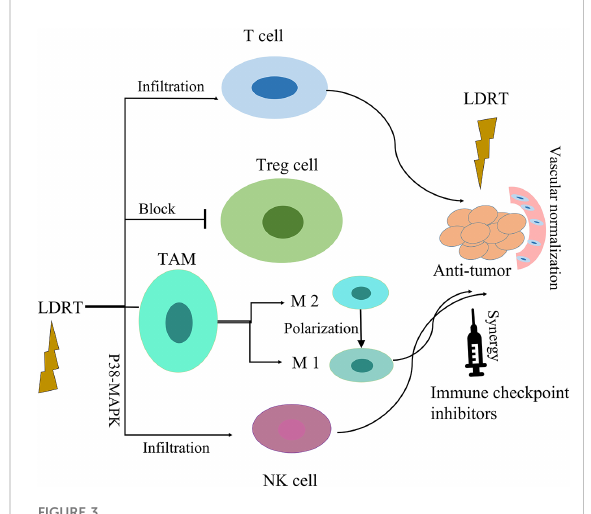
FIGURE 3 Immunomodulatory effects of LDRT in tumor microenvironment. LDRT modulates the tumor microenvironment by repolarizing macrophages to favor the M1 over the M2 phenotype, blocking regulatory T cells, and enhancing the in fi ltration of effector CD4 T cells and NK cells. Low-dose radiation can improve the ef fi cacy of immune checkpoint